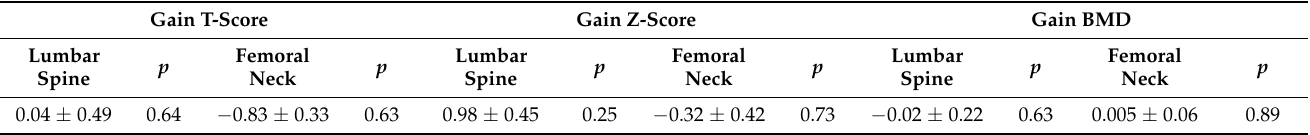
Table 4. T-score, Z-score, and BMD (g/cm 2 ) gains at 2 to 3 years follow-up in kidney transplant